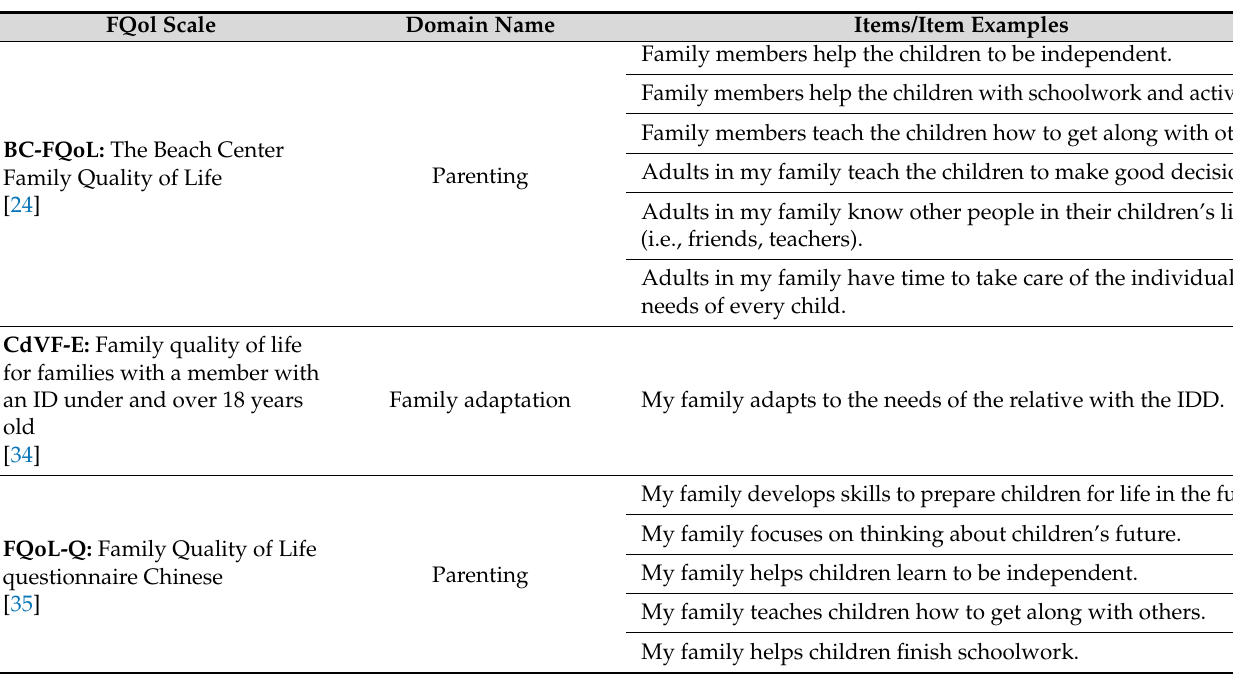
Table 3. Items/item examples considered in the domain of parenting within each FQoL scale.